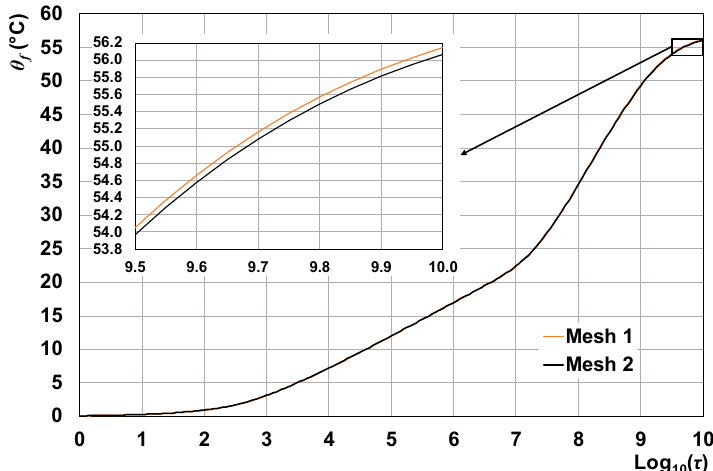
Figure 6. Isoflux fluid-to-ground thermal response of the 2 × 2 borefield versus log 10 ( τ ), with Mesh 1 (680,000 elements) and with Mesh 2 (1,800,000 elements).